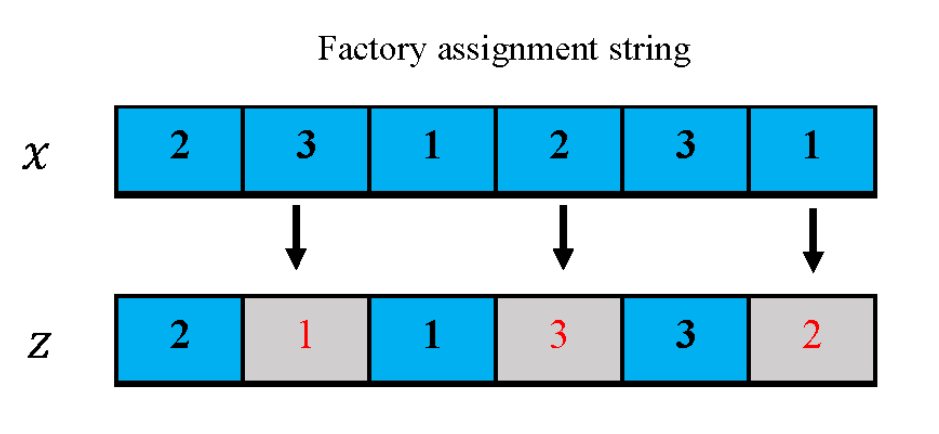
Figure 4. Example of reassignment